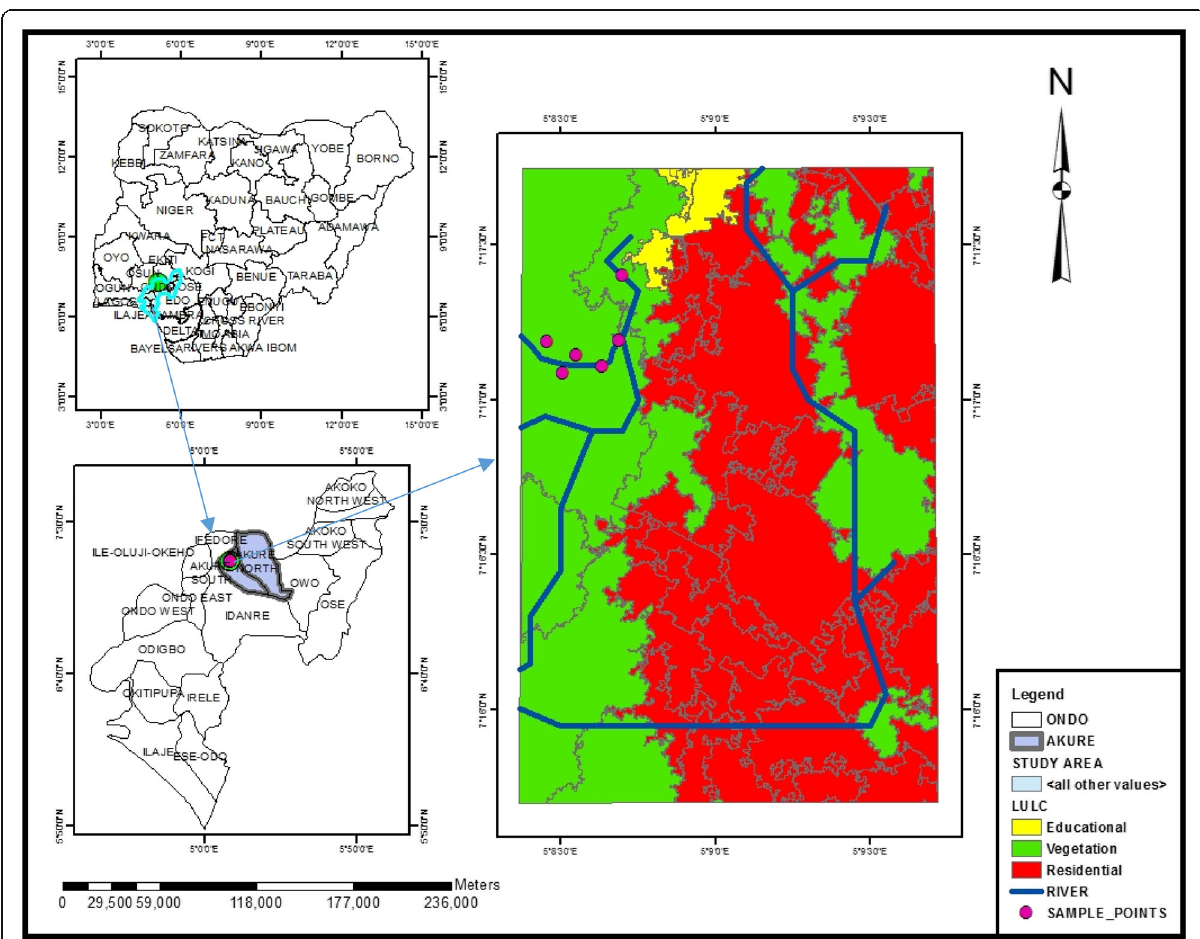
Fig. 1 Map showing the six study sites on Aahoo stream, Iloyin community, Akure, Ondo state,